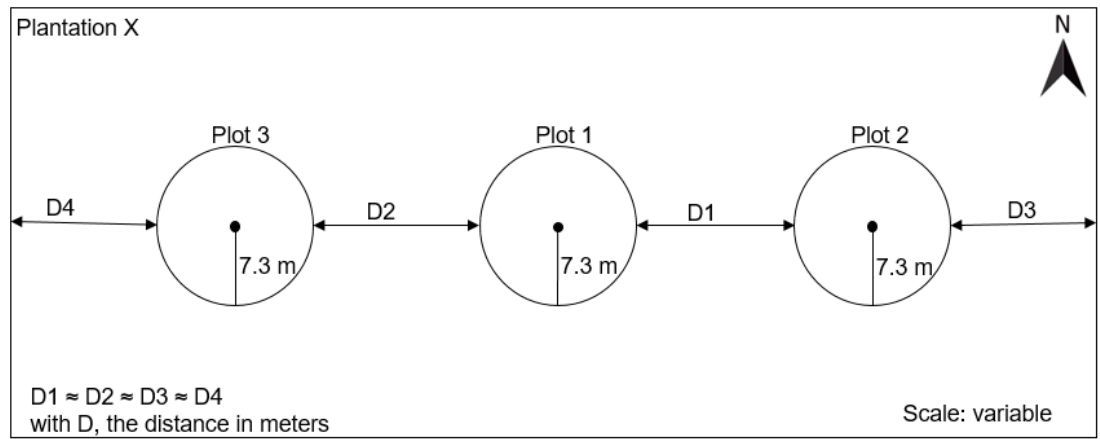
Figure 2. Theoretical inventory design. Figure 3. Theoretical inventory